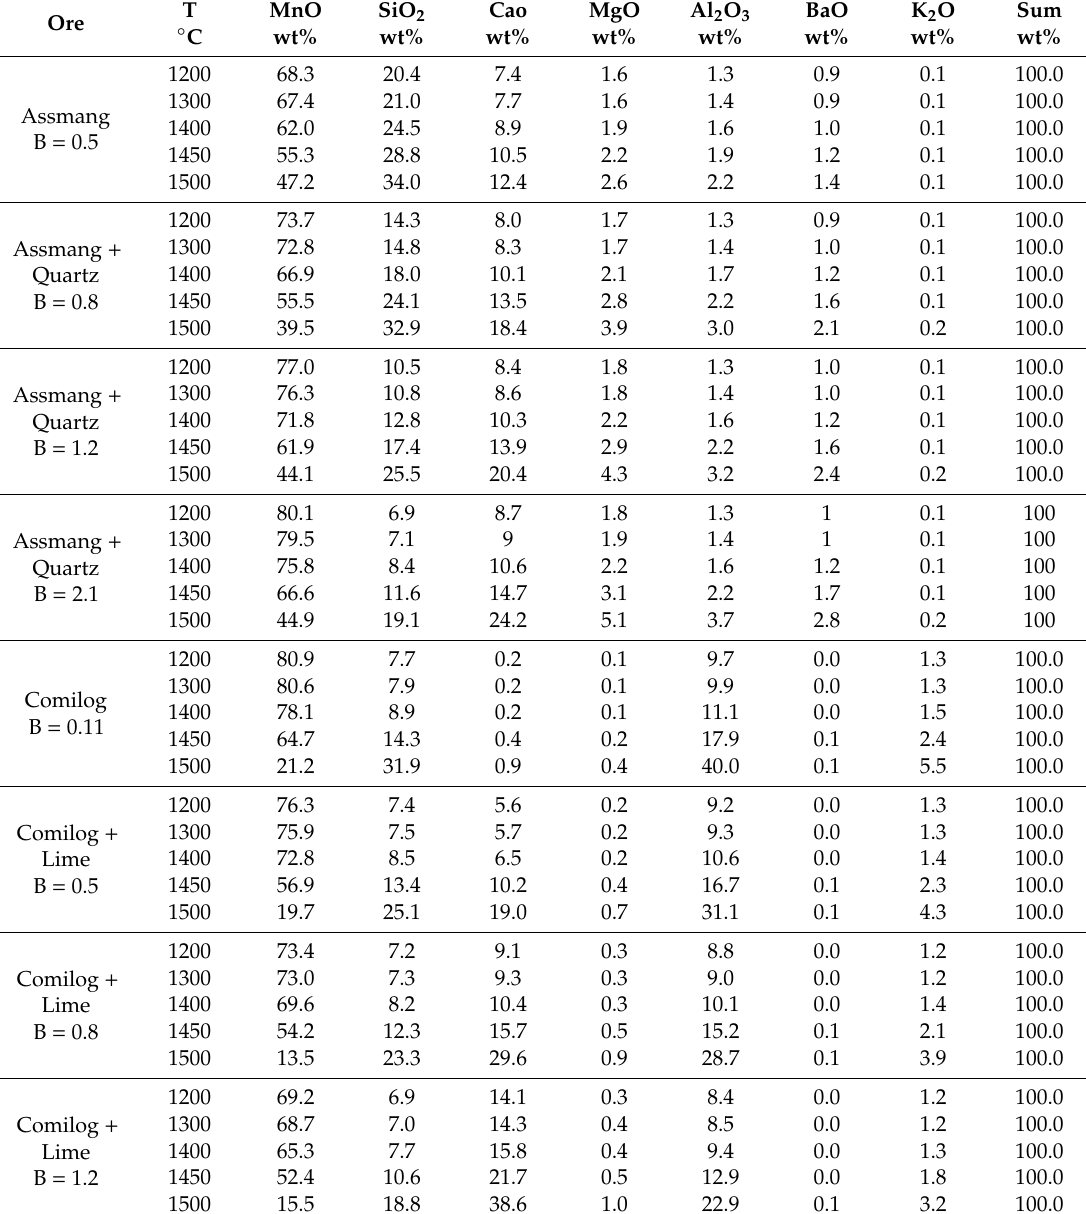
Table 3. Calculated slag composition based on weight loss